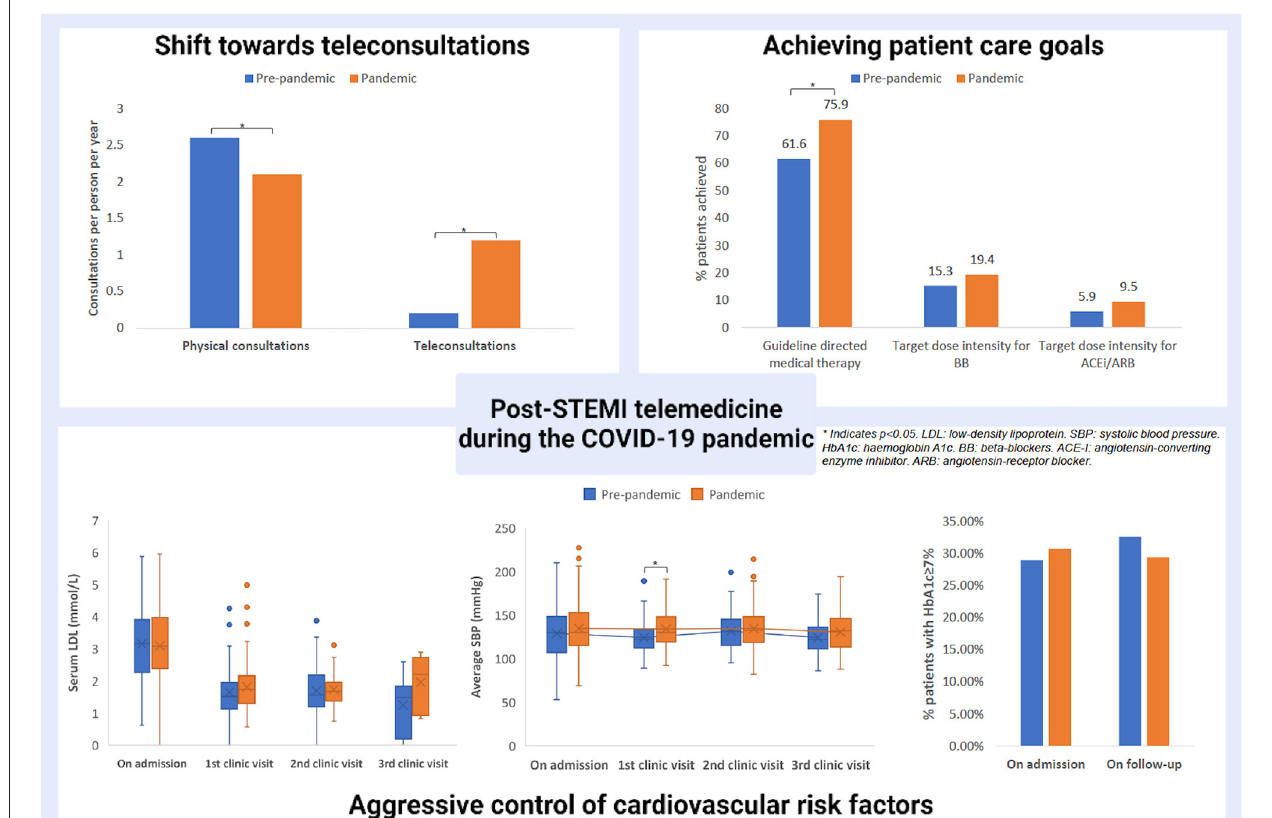
FIGURE 1 | Strategies in post-STEMI care and the emergence of telemedicine during the pandemic. * indicates p < 0.05.